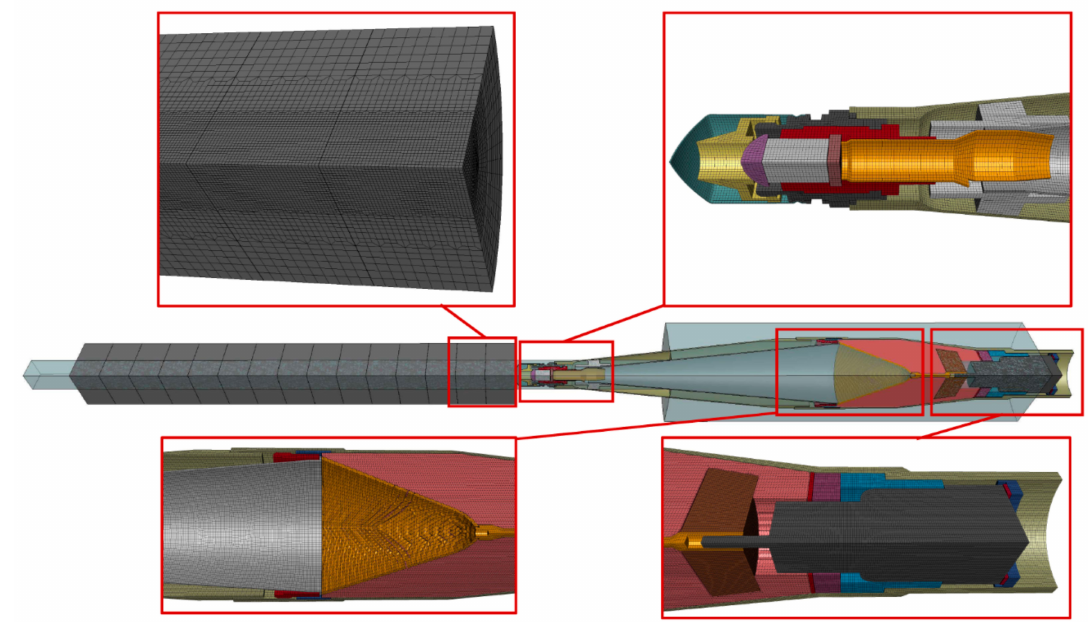
Figure 9. Discretization of the simulation